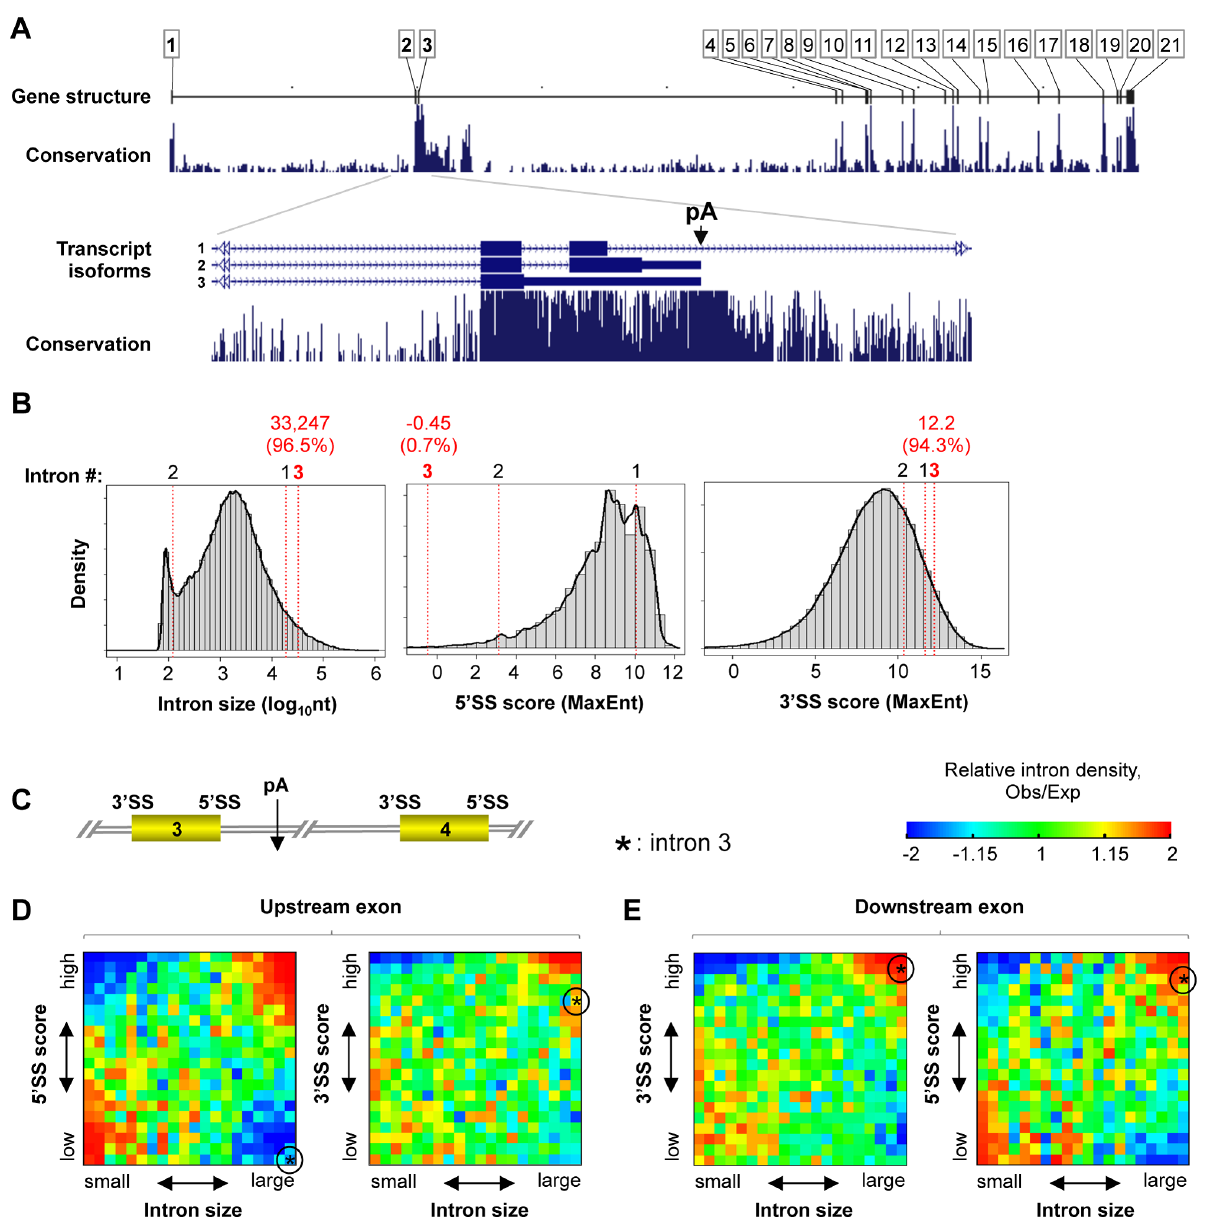
Figure 1. The intron 3 of human CstF-77 gene ( CTSF3 ) has several unique, conserved features. ( A ) Gene structure of CSTF3 , encoding the C/P factor CstF-77. Exons are numbered. A pA in intron 3 leads to APA isoforms 2 and 3 (isoform 3 has retention of intron 2). The conservation profile is based on vertebrate genomes. ( B ) Histograms of intron size, 5 9 SS maximum entropy (MaxEnt) score, and 3 9 SS MaxEnt score for all RefSeq- supported introns in the human genome. Red lines indicate introns 1–3 of CSTF3 . For each feature of intron 3, its value and percent of introns with a lower value are indicated. ( C ) Schematic of intron 3 flanked by exons 3 and 4. ( D ) Density maps of introns in the human genome based on the 5 9 SS or 3 9 SS score of upstream exon and intron size. Intron density map is a heatmap showing distribution of introns with respect to two parameters (x-axis and y-axis). Left, 5 9 SS vs. intron size; right, 3 9 SS vs. intron size. Relative density is based on ratio of observed values to expected values (see Materials and Methods for detail), and is represented by colors using the color scale shown on the top. ( E ) As in (D), except that downstream 5 9 SS and 3 9 SS scores were used. The intron 3 of CSTF3 is indicated by a circled asterisk in each graph.